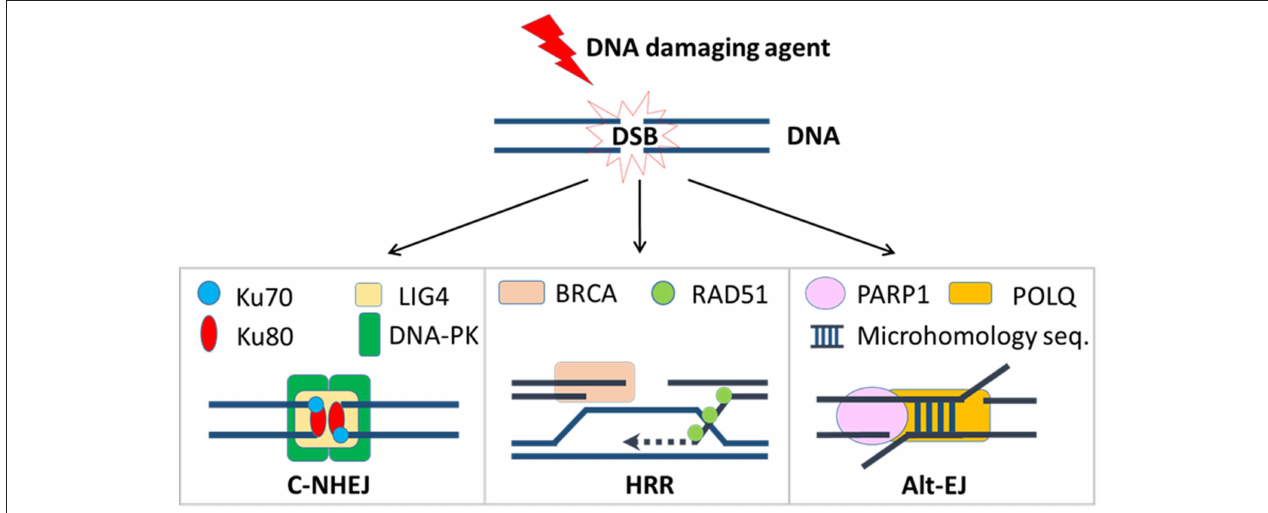
FIGURE 1 | DSB repair pathways. Once a DSB is induced by a DNA damaging agent, cancer cells will try to repair it by one of these three mechanisms. Critical repair proteins in each pathway are